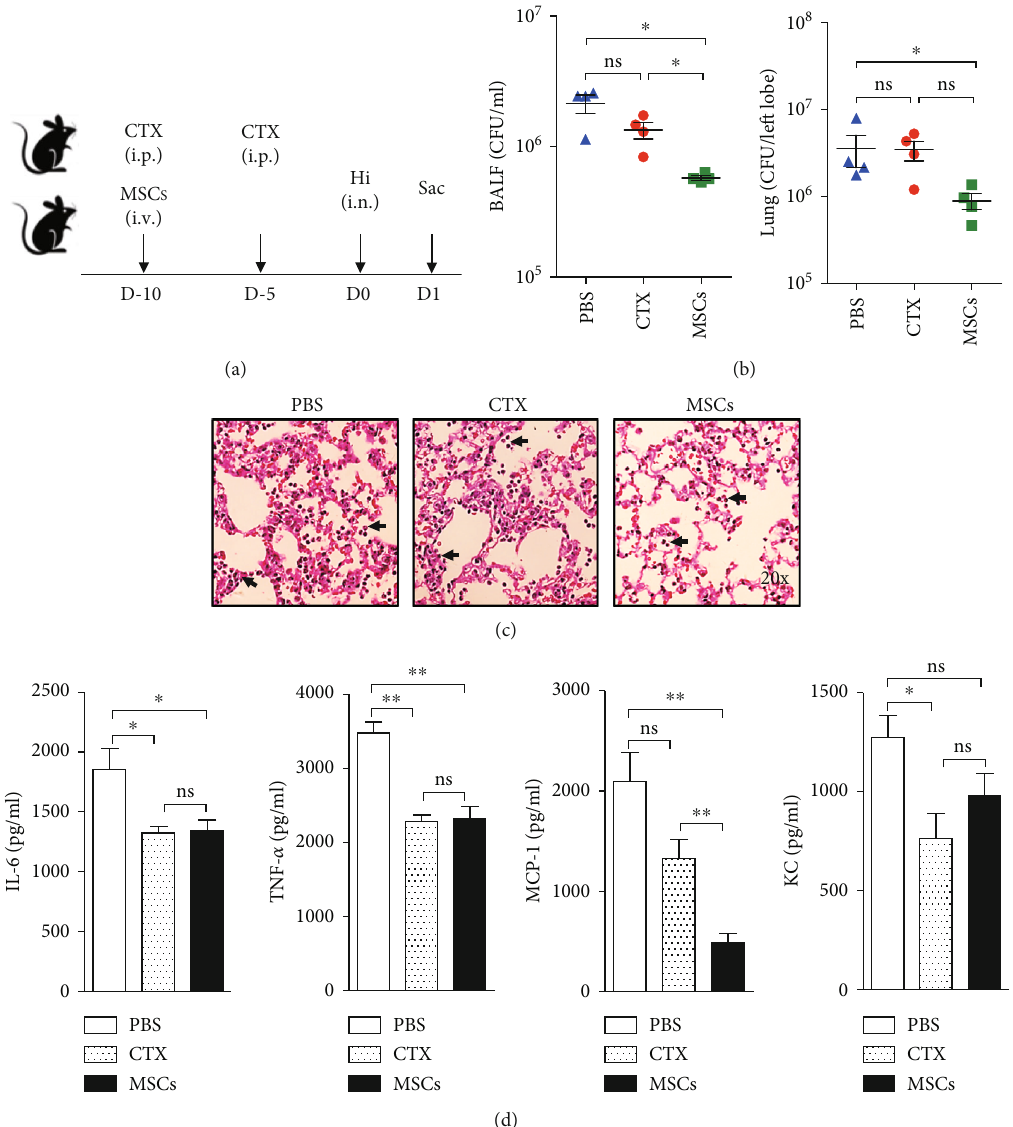
Figure 5: Pretreatment with MSCs provides protection against pulmonary bacterial infection. (a) MSC- or CTX-treated mice were infected by 1 × 10 8 CFU of Hi. PBS-treated mice were used as controls. (b) Twenty-four hours later, mice were sacri fi ced and bacteria in the BALF and lung were numerated. (c) Lung pathology was examined by H&E staining. Arrowheads indicated in fi ltrated neutrophils. (d) In fl ammatory- related cytokines IL-6 and TNF- α and chemokines MCP-1 and KC in the BALF collected from infected mice were measured by ELISA. Data were expressed as the means ± SEM . n = 4 mice for each treatment group; ∗ p < 0 : 05 ; ∗∗ p < 0 : 01 ; ns: no signi fi cant di ff erence. This experiment is representative of three individual